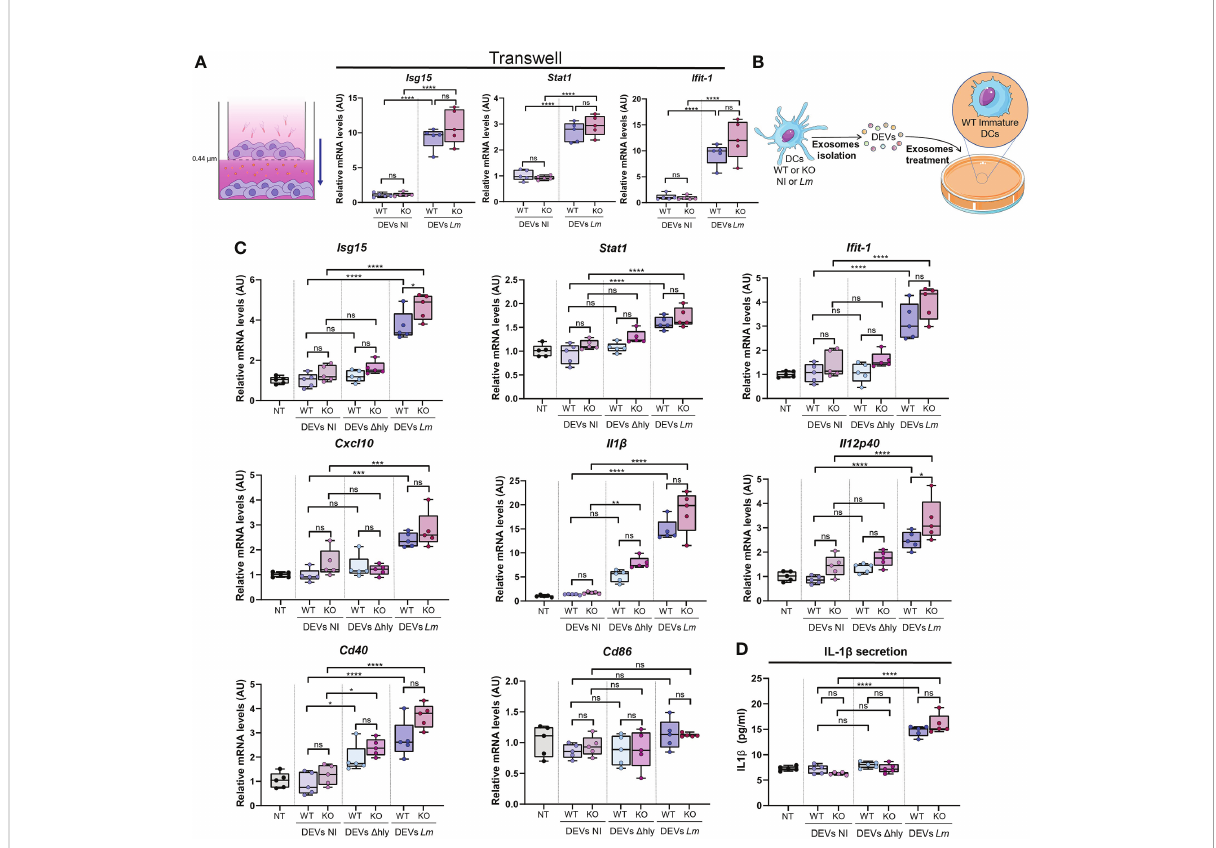
FIGURE 5 DEVs isolated from Lm -infected BMDCs induce gene expression of anti-pathogenic genes in immature BMDCs. (A) BMDCs were infected or not with Lm (upper chamber) and co-cultured in contact with other immature BMDCs (lower chamber) through a 0.4 µm pore membrane. qPCR analysis was performed in BMDCs cultured in the lower chamber for Isg15, Stat1 and I fi t-1 genes ( n= 5, one-way analysis of variance (ANOVA) test with Tukey ’ s posttest; **** P < 0.0001 and ns, not signi fi cant). Values were normalized with Ywhaz and b -Actin housekeeping genes. (B) Isolated DEVs by ultracentrifugation from Lm -infected (DEVs Lm ) or non-infected (DEVs NI) Hdac6 +/+ (WT) or Hdac6 -/- (KO) DCs were added to wild-type immature DCs for 24h. (C) qPCR analysis of the expression levels of Isg15, Stat1, I fi t-1, Cxcl10, Il1 b , Il12 p40, Cd40 and Cd86 in DCs treated with vehicle (NT), isolated DEVs from non-infected DCs (NI), D hly Lm strain-infected ( D hly ) or Lm -infected ( Lm ) ( n= 5, one-way ANOVA test with Tukey ’ s posttest; * P < 0.05, *** P < 0.001, **** P < 0.0001 and ns, not signi fi cant). Ywhaz and b -Actin were used as housekeeping genes. (D) ELISA analysis in DEVs-treated DCs of IL-1 b . Immature DCs were treated with DEVs from non-infected DCs (NI), D hly Lm strain- infected ( D hly ) or Lm -infected ( Lm ) ( n= 5, one-way ANOVA test with Tukey ’ s posttest; **** P < 0.0001 and ns, not signi fi